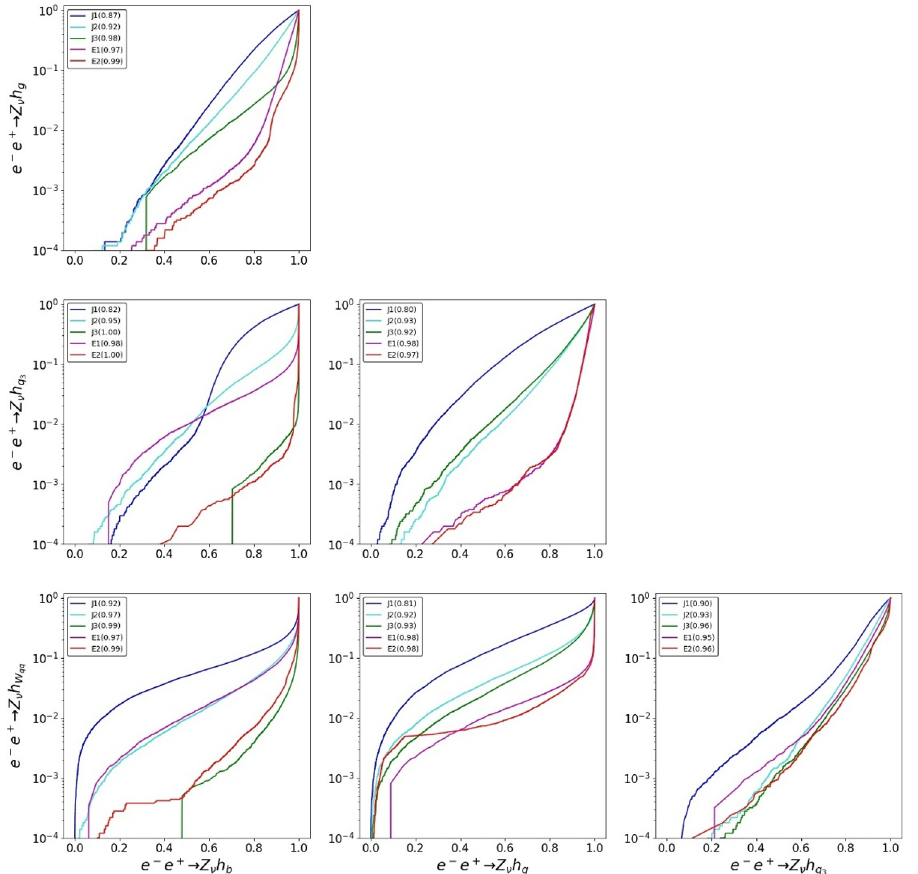
Figure 8 . ROC curves and their AUC for the binary classi(cid:12)ers to distinguish between the four classes of two-jet